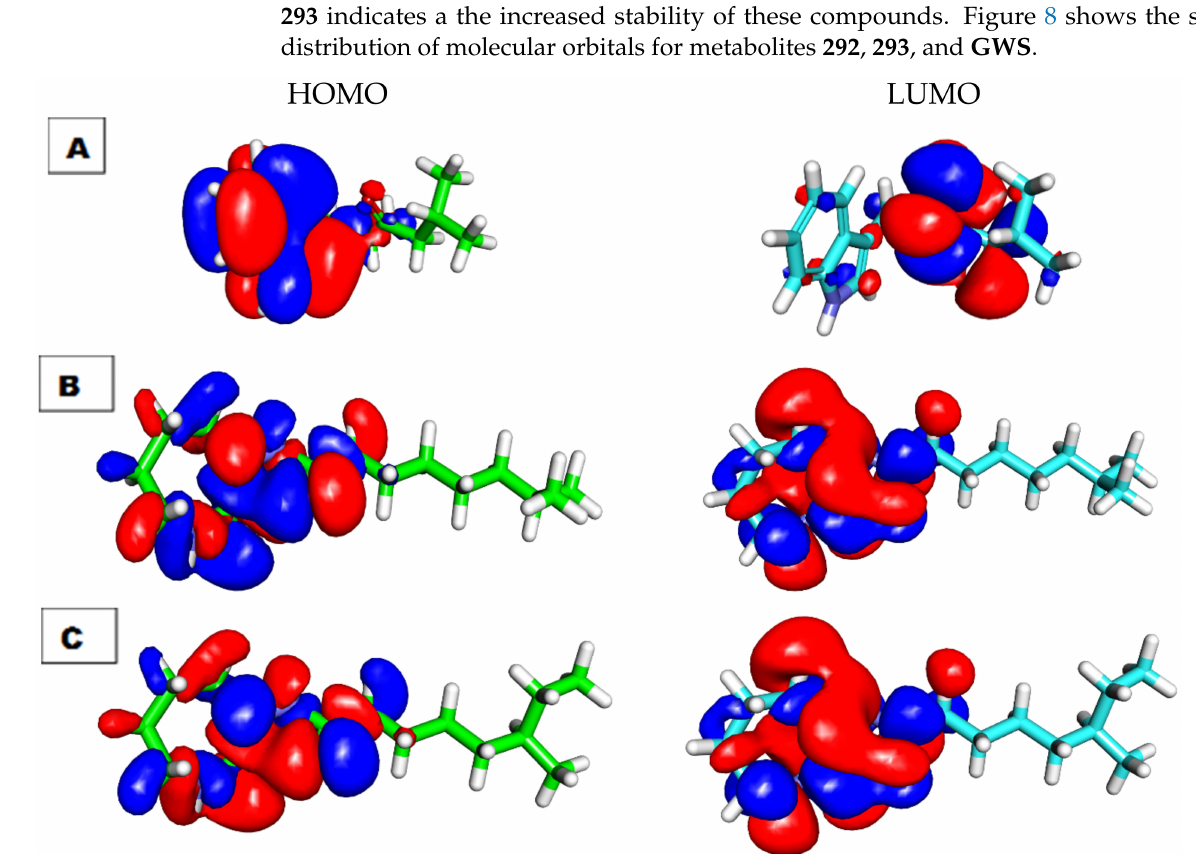
Figure 8. Spatial distribution of molecular orbitals for ( A ) GWS , as well as metabolites ( B ) 292 and ( C ) 293